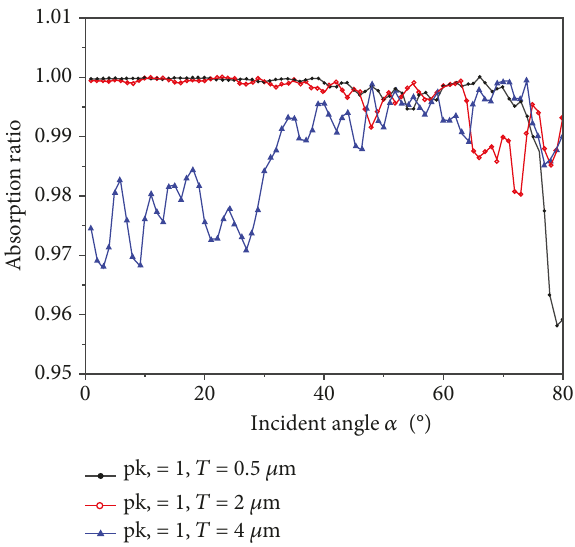
Figure 12: Absorptivity varying curve of random surface structure with di ff erent T